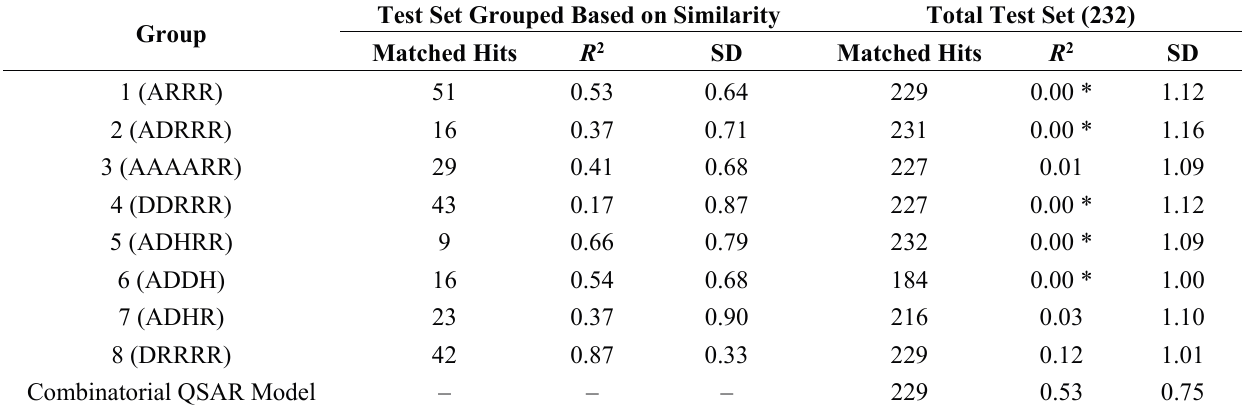
Figure 2. Scatter plot of the observed versus predicted activity generated by the combinatorial 3D-QSAR model of ( A ) the training set and ( B ) the test set. Table 2. Prediction performance of single QSAR model and combinatorial QSAR model on test